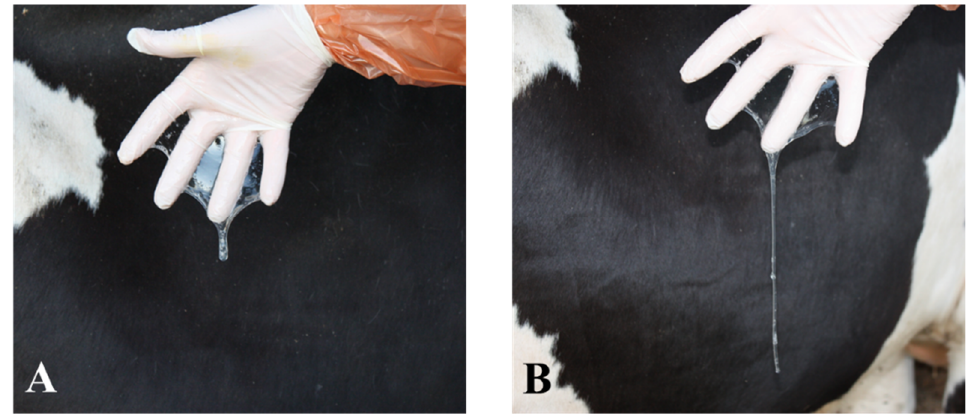
Figure 1. Cervical mucus viscosity can be used to differentiate between early estrus (mucus less hydrated) ( A ), and late estrus (mucus more hydrated) ( B ) [73–76]. Mucus samples were obtained from the cranial vagina with the help of a plastic inseminating sheath attached to a 50 mL syringe [75]. The time interval from A to B was 16 h.